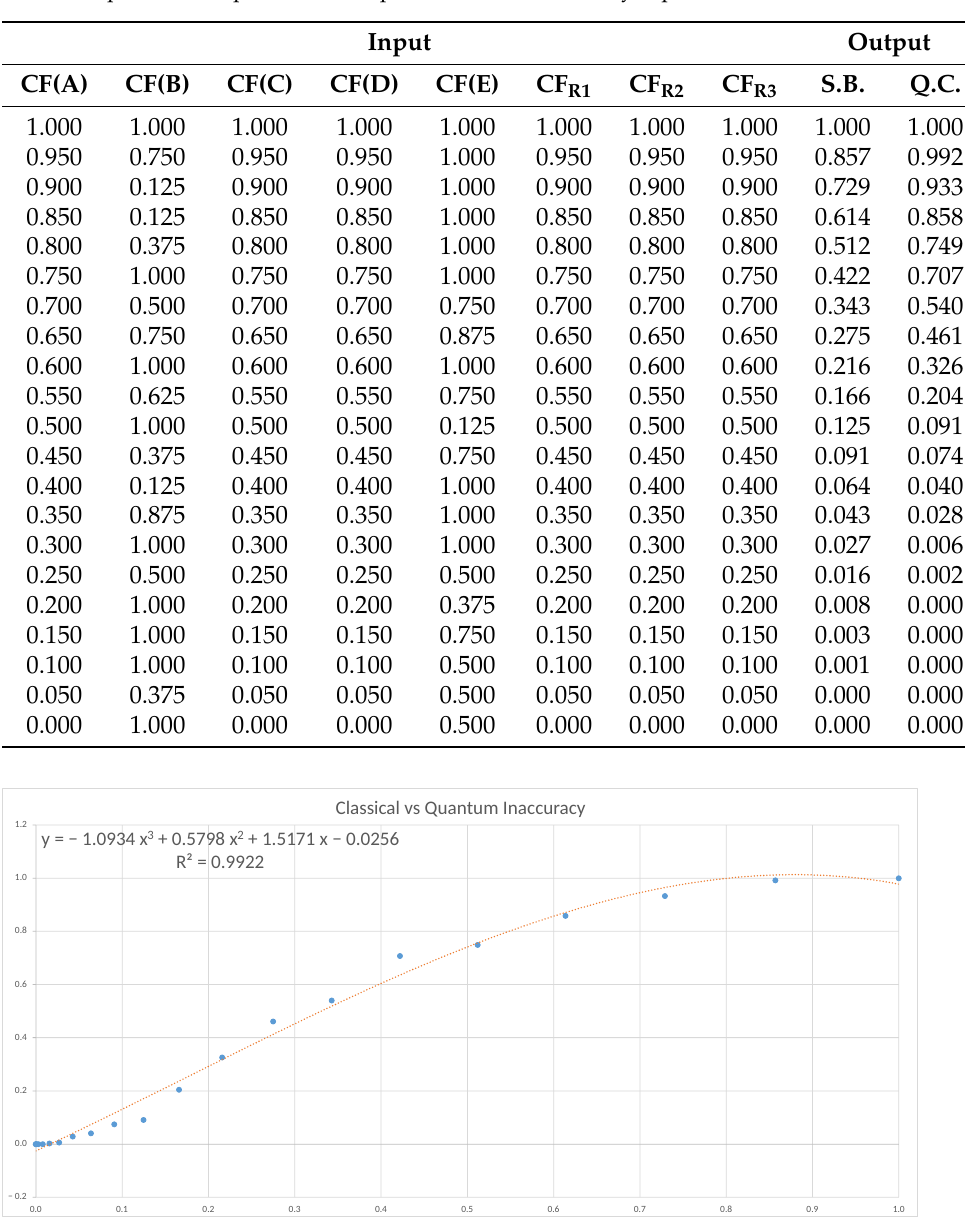
Table 9. Inputs and outputs for the imprecision and uncertainty experiment.